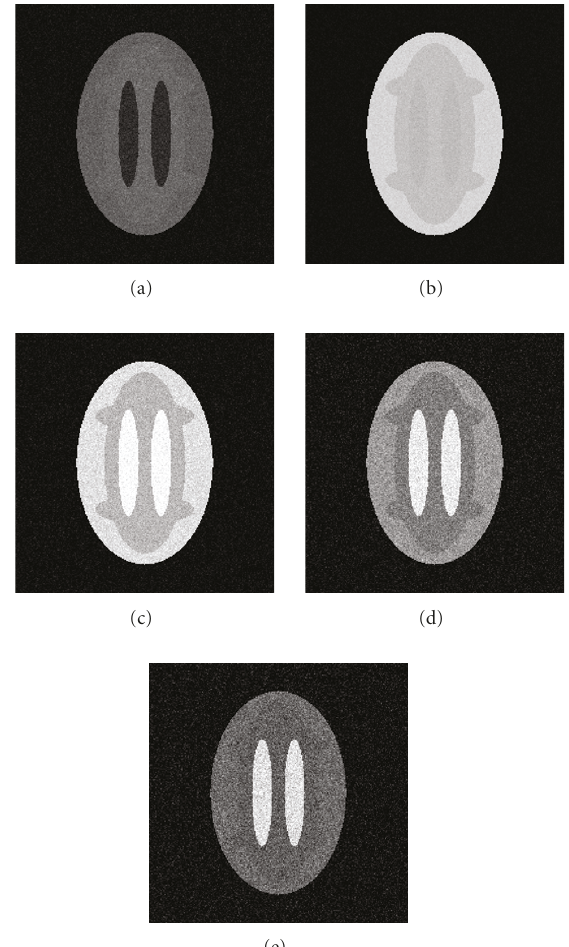
Figure 7: Simulated brain MRIs with 5dB noise: (a) Sequence 1; (b) Sequence 2; (c) Sequence 3; (d) Sequence 4; and (e) Sequence 5.